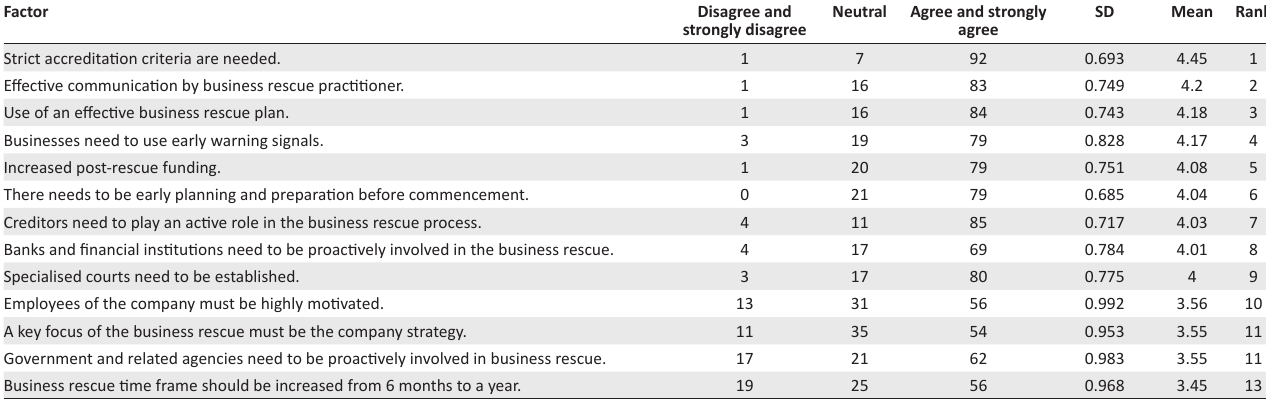
TABLE 3: Business rescue success factors and ranking.